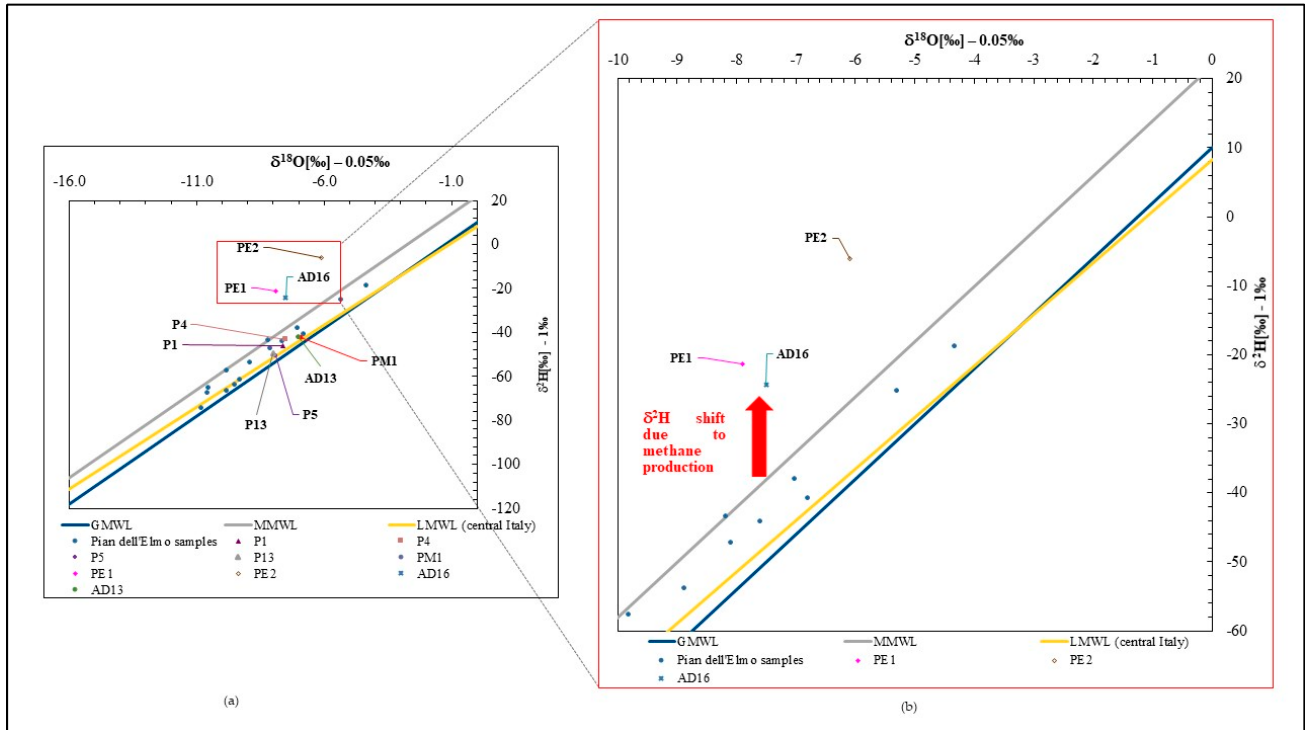
Figure 7. δ 2 H vs. δ 18 O values for Case History II: all samples ( a ) and PE1, PE2 & AD16 ( b ). The Pian dell’Elmo pluviometric station has been identified and referred to, as it is placed at north-east to the study area (Figure 3), and its isotopic data are provided by the International Atomic Energy Agency